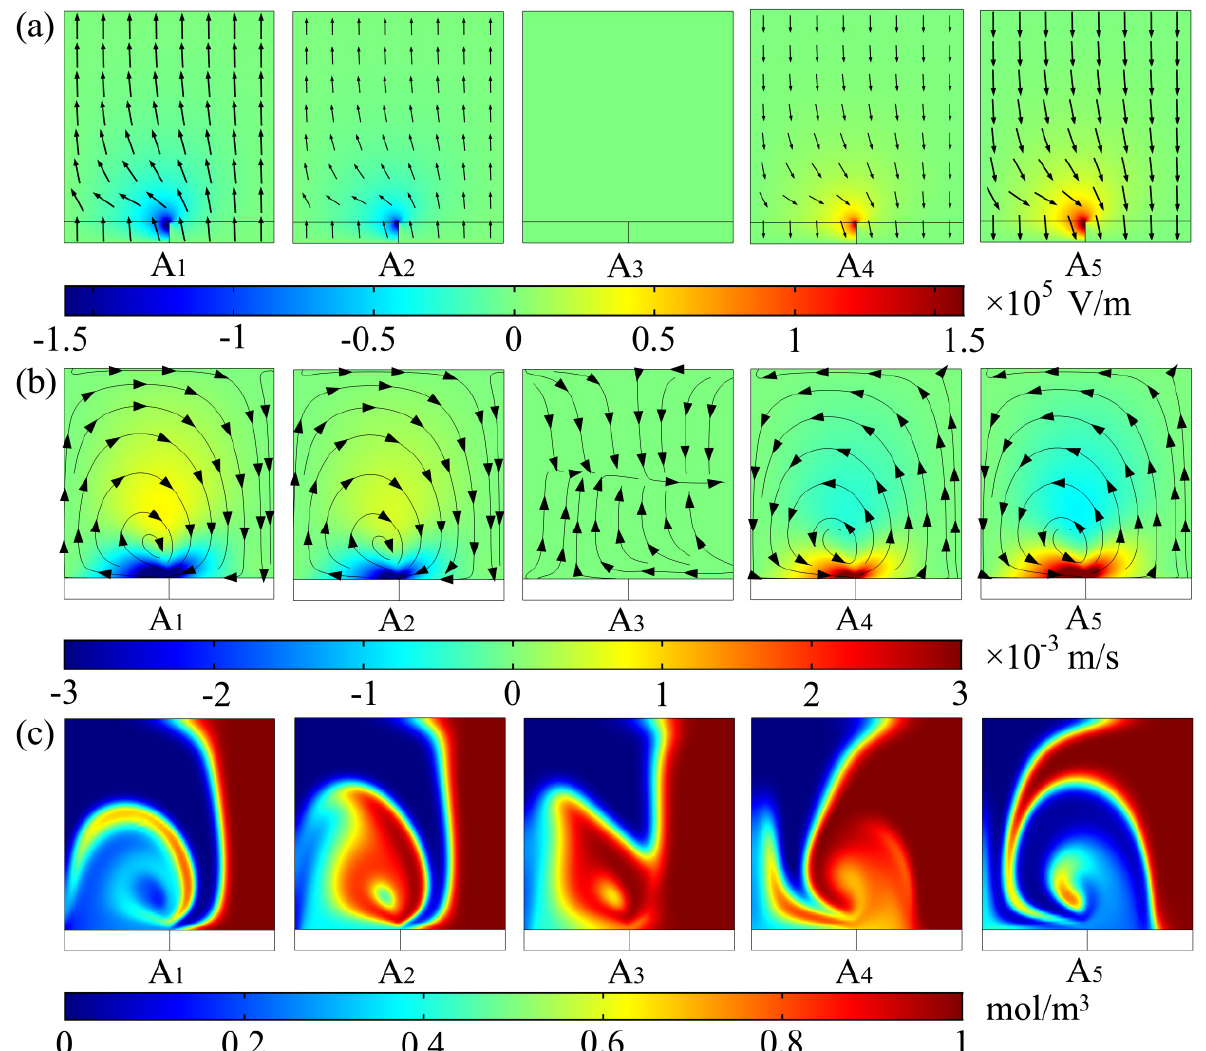
Figure 3. ( a ) Y component of applied potential, ( b ) flow field, and ( c ) concentration-distribution evolution of A–A cross- section in the microchannel at five different moments during one cycle. A, cross-section in the microchannel, and subscript i represents different moments (A 1 ) t = 1/4 T, (A 2 ) t = 3/8 T, (A 3 ) t = 1/2 T, (A 4 ) t = 5/8 T and (A 5 ) t = 3/4 T. Peak-to-peak value of applied potential was V 0 = 1 V, electric-field frequency was f = 5 Hz, and inlet mean velocity was U m = 2 × 10 –4 m/s. Length was L o = 10 μ m, width was W o = 10 μ m and spacing was S o = 10 μ m of the virtual electrode. Aspect ratio of the microchannel was W c / H c = 1. ( a ) Black arrows, electric-field intensity vectors; and color legend, magnitude of E y . ( b ) Black lines, streamlines; black arrows, flow direction; color legend, magnitude of velocity component in y direction. ( c ) Color legend, concentration distribution from 0 to 1 mol/m 3 .